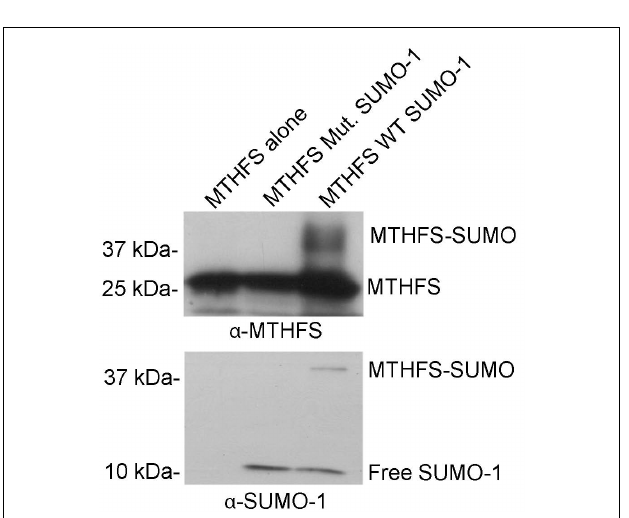
FIGURE 10 | Sumo Immunoprecipitation. The MTHFS-GFP fusion protein was expressed in HeLa cells maintained in purine-deficient RPMI-1640 using Lipofectamine 2000 (Invitrogen), as described above. Mock transfection contained only Lipofectamine 2000. Cell extracts (180 μ g/sample) were incubated with 4 μ g α -SUMO-1 antibody (Active Motif) overnight at 4˚C. Dynabeads Protein G (Invitrogen) were used to pull down protein complexes, which were eluted using 1 × SDS-PAGE sample buffer and resolved on a 12% SDS-PAGE acrylamide gel. Membranes were probed with 1:5,000 dilution of sheep anti-mouse MTHFS antibody (described in section Materials and methods).